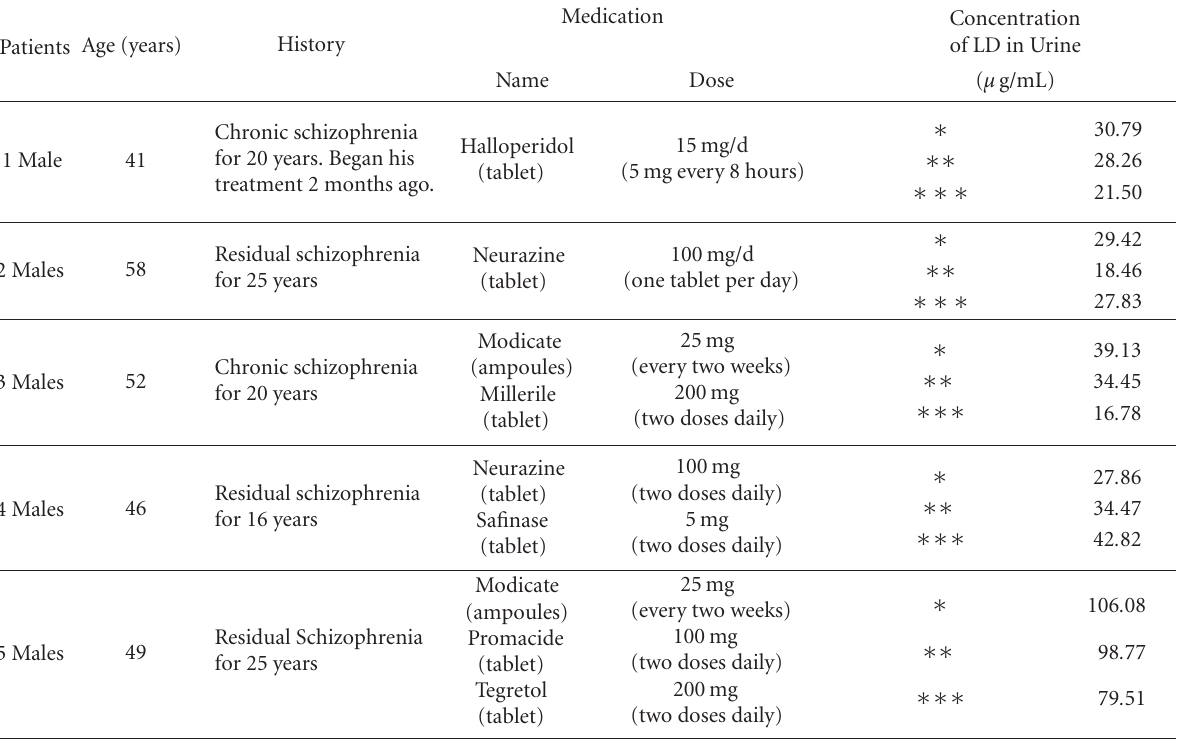
Table 5. Determination of LD in the urine samples of schizophrenic patients using copper (II) complex and 4-AAP under selected and optimum pH, temperature, time, and wavelength.